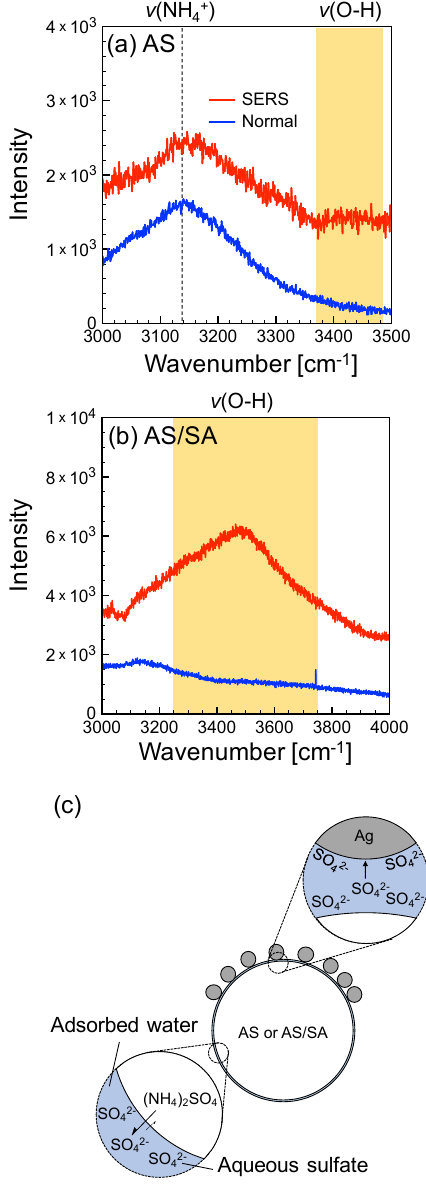
Figure 9. Normal (blue) and enhanced (red) Raman spectra of (a) AS and (b) AS / SA particles at 3000–4000cm − 1 . The sizes of the AS particles are 31.6 and 30.3µm for normal Raman and SERS experiments, respectively. The sizes of the AS / SA particles are 24.7 and 25.5µm for normal Raman and SERS experiments, re- spectively. (c) Schematic representation (not to scale) of a possible role of surface-adsorbed water in facilitating dissolution of aqueous sulfate anions that are subsequently chemisorbed on the surface of an Ag